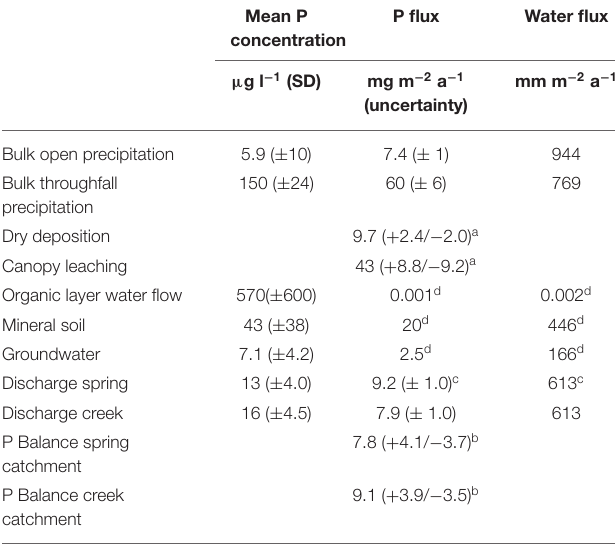
TABLE 1 | Concentrations and fluxes of P and water in the study